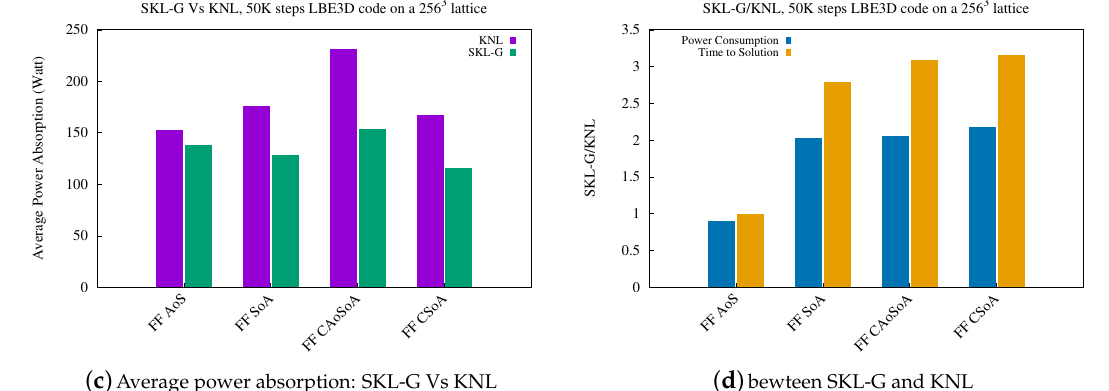
Figure 7. The figure reports an overview of the energy efficiency, when comparing the SKL-G and the KNL processors on the same simulation using the LBE3D. In all cases only the the fully fused version of the LBE3D is reported, to compare the two architectures in respect to the most optimized configuration. In ( a ) we compare the energy consumption, while in ( b ) we provide a view of the time to